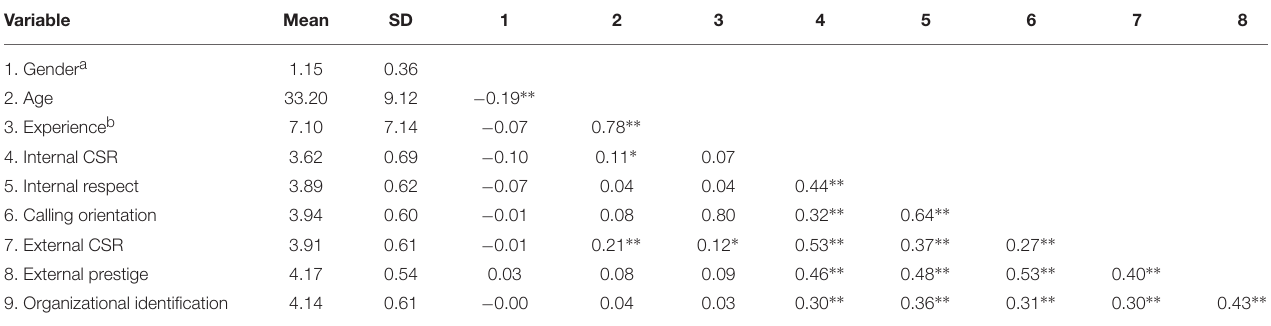
TABLE 1 | Descriptive statistics.